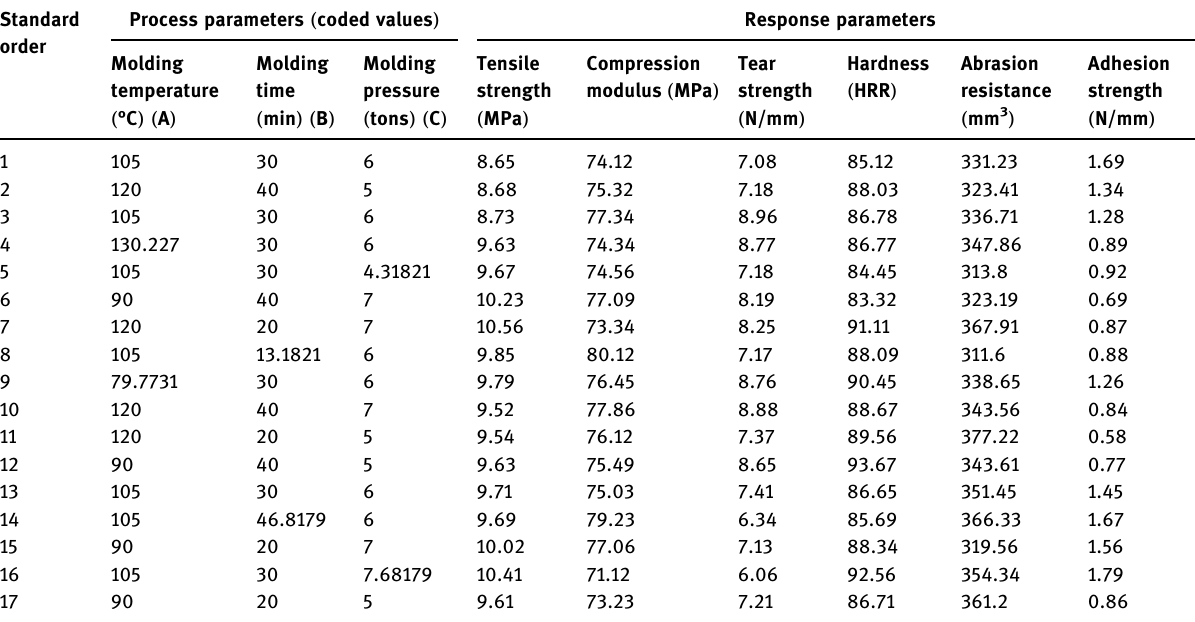
Table 6: Arrangement of experimental design matrix in terms of coded values ( levels ) based on the CCD for six input process parameters for leather bu ffi ng dust reinforced recycled EVA polymer composites